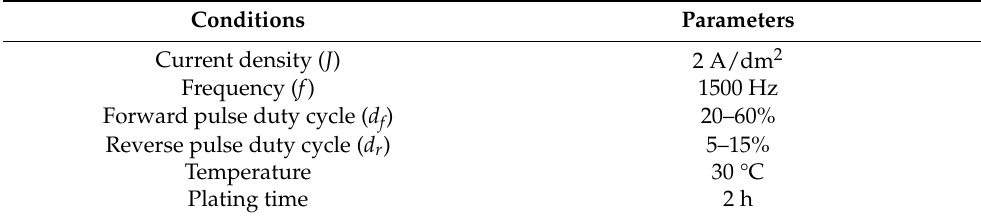
Table 1. The parameters of the electroplating process.